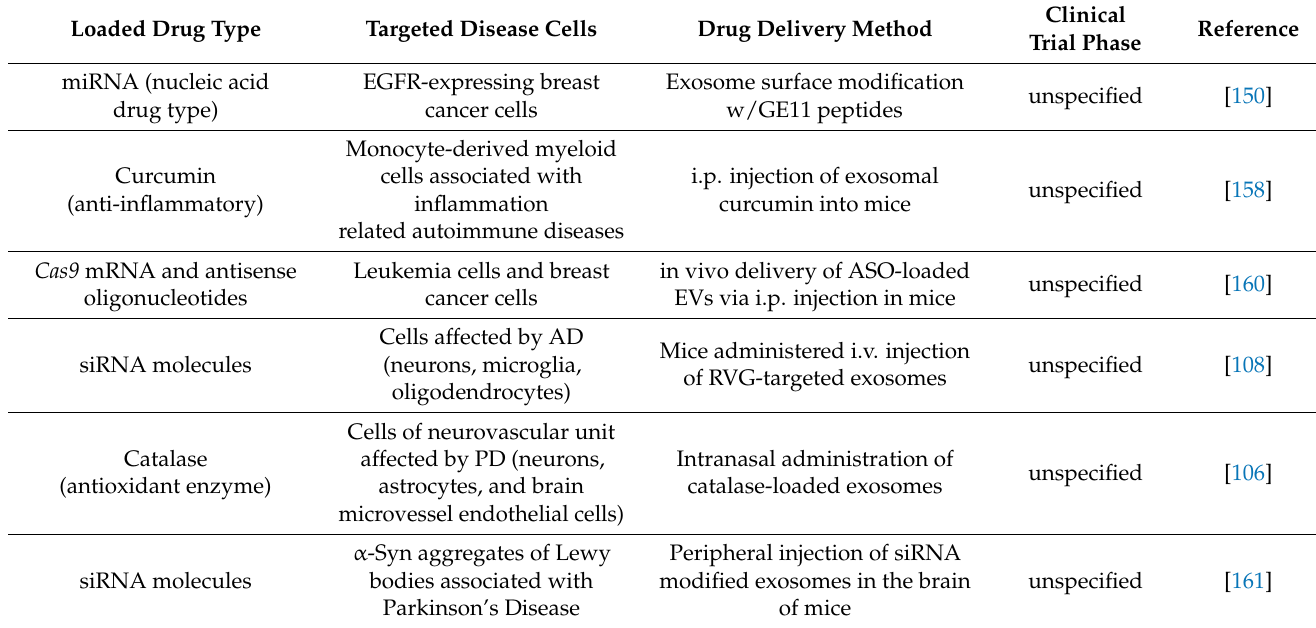
Table 2. Extracellular vesicles-based therapies in preclinical